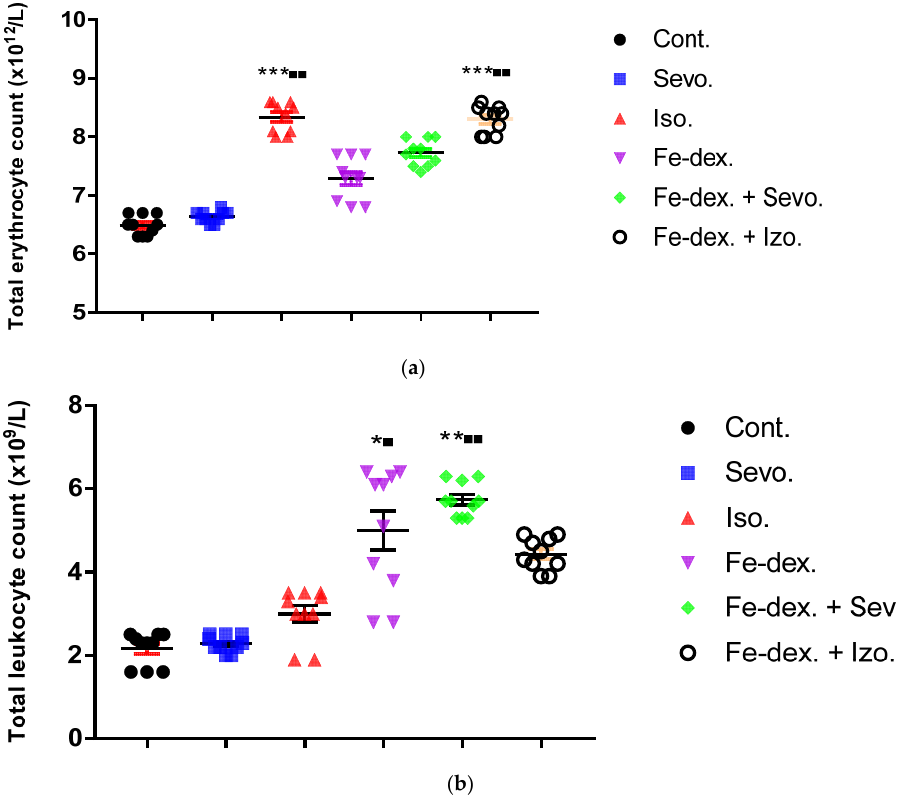
Figure 3. Total number of erythrocytes ( a ) and leukocytes ( b ) in the blood of rats treated with inhaled anesthetics and iron dextran and their combination. Rats ( n = 10 per group) were treated with ip injection of iron dextran (50 mg/kg), exposed to 2.4 vol % sevoflurane inhalation and 1.3 vol % isoflurane inhalation, and exposed to a combination thereof where inhaled anesthetics were given 2 h after ip injection of iron dextran. Animals were treated every other day for 28 days. Each animal sample is indicated by a single dot. The results are expressed as the mean value of each experimental group ± SE. * Statistically significant compared to the control group (* p < 0.05; ** p < 0.01; *** p < 0.001); ■ Statistically significant compared to the sevoflurane group ( ■ p < 0.05; ■■ p < 0.01). Abbreviations: Cont., control group; Sevo., sevoflurane group; Iso., isoflurane group; Fe-dex., iron dextran group; Fe-dex. + Sevo., group treated with iron dextran and sevoflurane; and Fe-dex. + Iso., group treated with iron dextran and isoflurane.